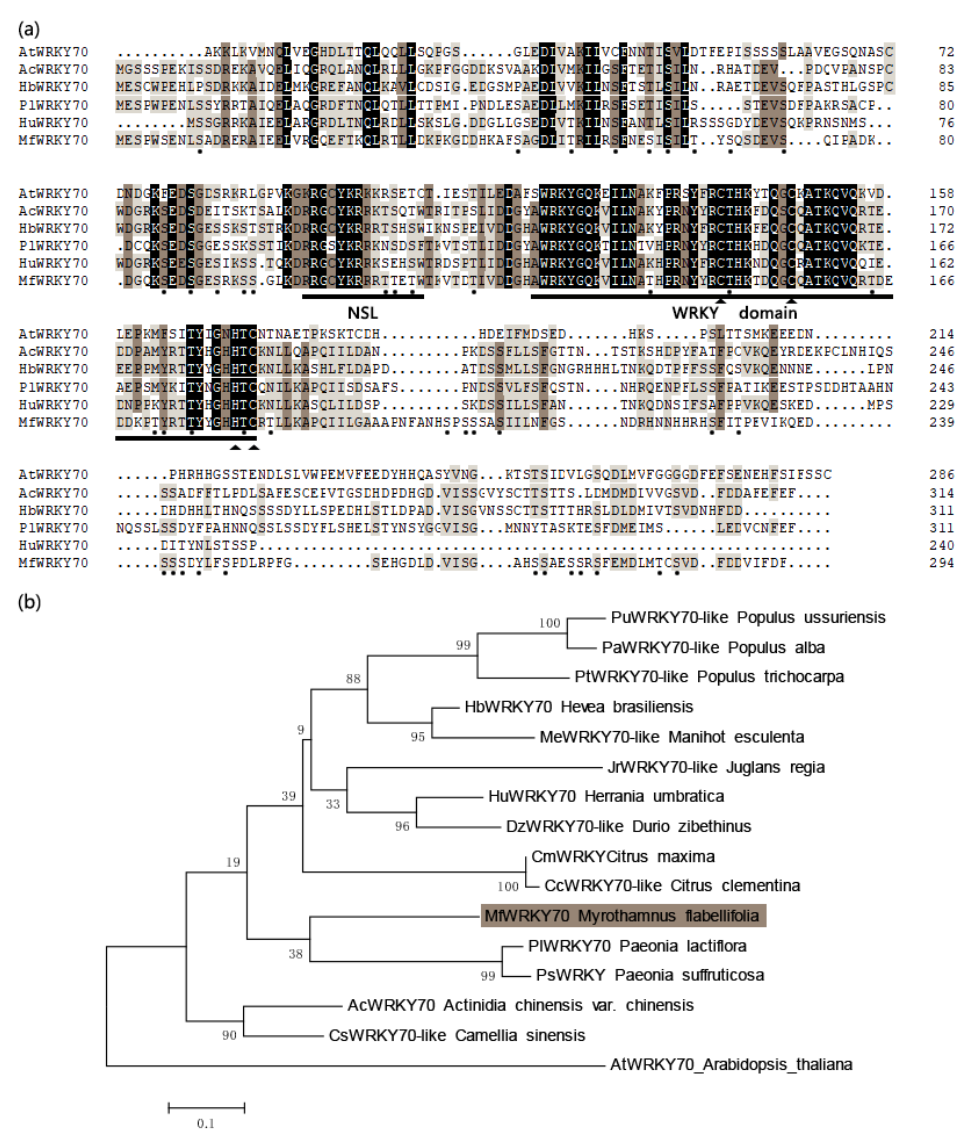
Figure 1. Sequence analysis and phylogenetic analysis of MfWRKY70. ( a ) Multiple alignment of deduced amino acid sequences; identical and similar amino acids are shaded in black and brown, the characteristic site of WRKY protein zinc finger structure is indicated by the arrowhead; phosphorylation sites are indicated by dots. ( b ) Phylogenetic tree constructed using the neighbor-joining method. MfWRKY70 is shaded. The GenBank accession numbers and corresponding species are listed in Supplementary Table S2.